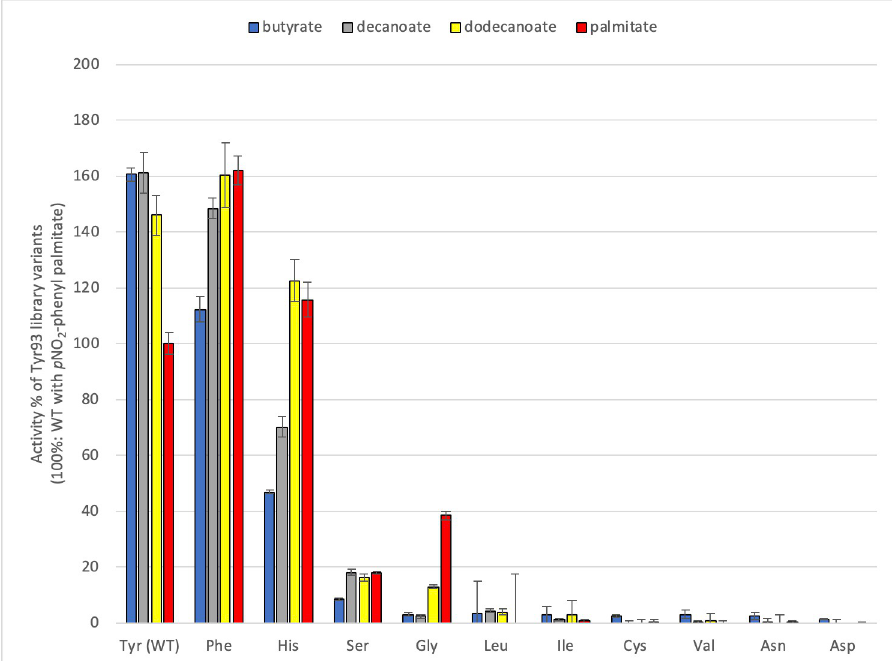
Fig 5. Hydrolytic activity of Tyr93 library variants with p -NO 2 -phenyl fatty acids. Assays were performed in triplicate with clarified E . coli lysates. Activity is reported relative to WT Cal-A with p NO 2 -phenyl-palmitate. Its specific activity (S.A) = 0.4 U/mg, is set as